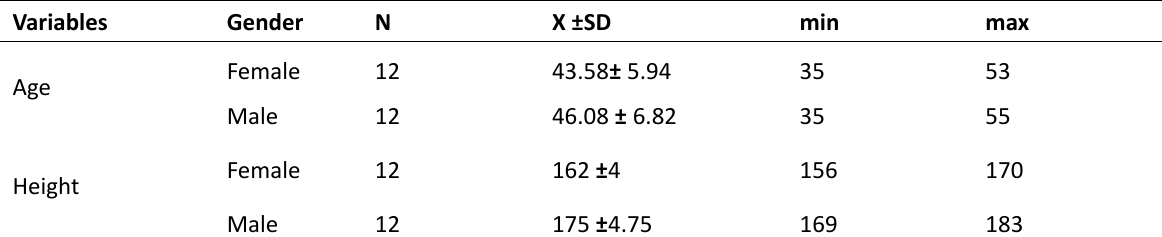
Table 1. Demographical information of the participants Variables